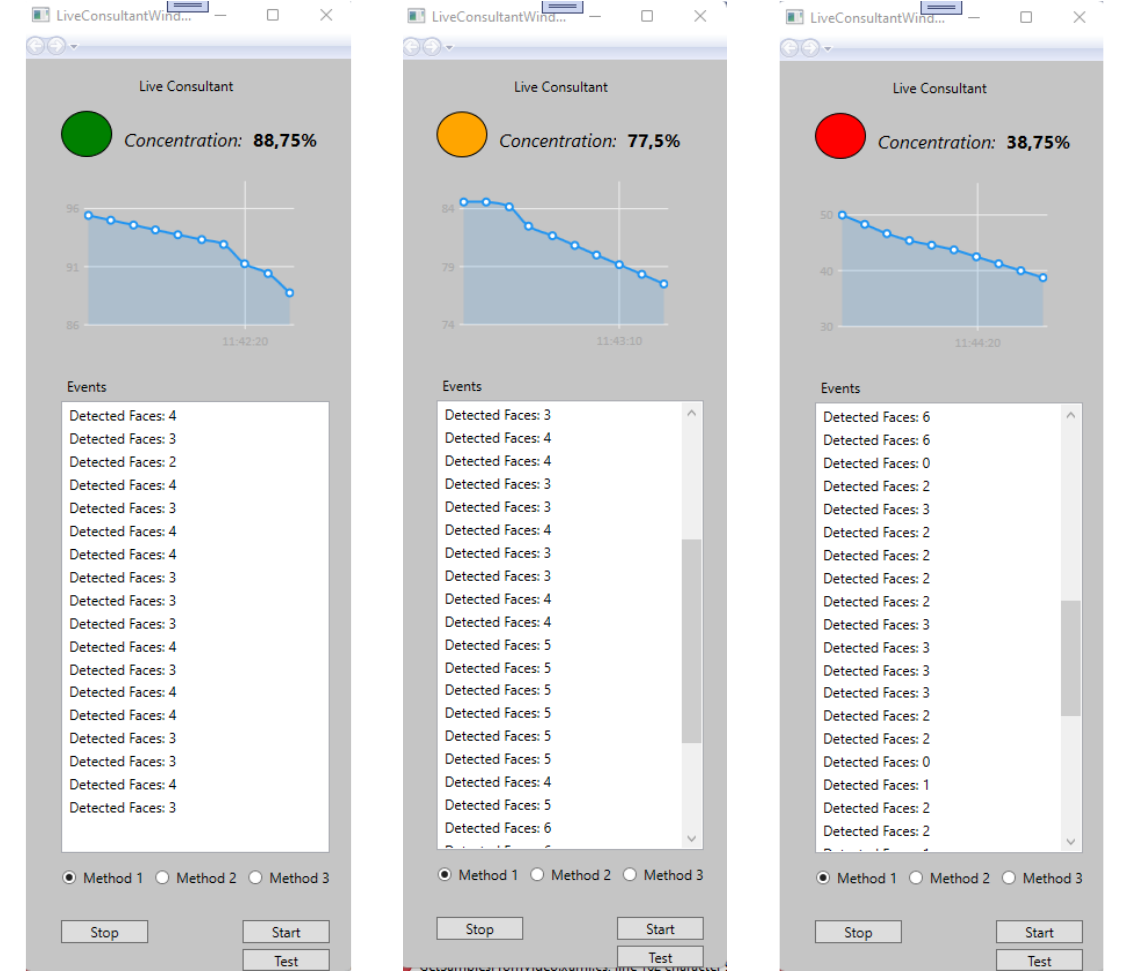
Figure 4. Live Consultant Window. The new UI features are presented in Figure 5.